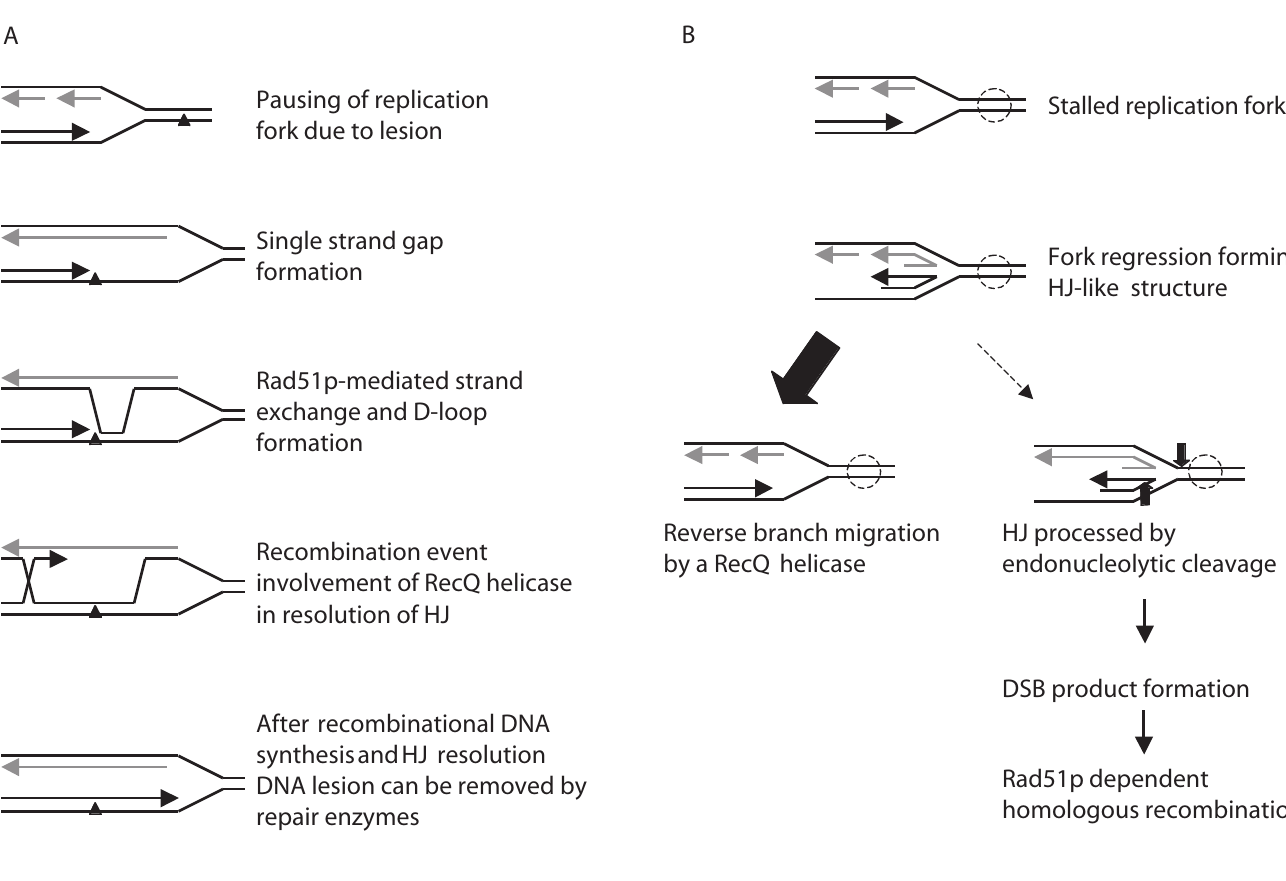
Figure 3 Dual roles for RecQ helicases in replication-associated DNA damage. A. A model for the function of RecQ helicases in recombinational DNA repair. When a replication fork encounters a block (shown as a triangle), a single strand gap forms at the stalled fork. This region can be used for a Rad51p dependent strand exchange and D-loop formation to initiate a recombination event. A RecQ helicase can associate with Rad51p and might be involved in the ensuing branch migration and/or joint molecule resolution. After recombinational DNA synthesis and resolution of the Holliday junction, the DNA lesion resides in a duplex, which is the preferred substrate for repair enzymes. B. A model for RecQ helicases as an anti-recombinase at sites of stalled replication. During replication pausing, the nascent DNA strands can disso- ciate from the template and anneal to each other, thereby forming a Holliday Junction-like structure. This structure might be reversed by RecQ helicases by branch migration or alternatively endonucleotlytic cleavage can occur, which will generate DSB products that can be repaired via homologous